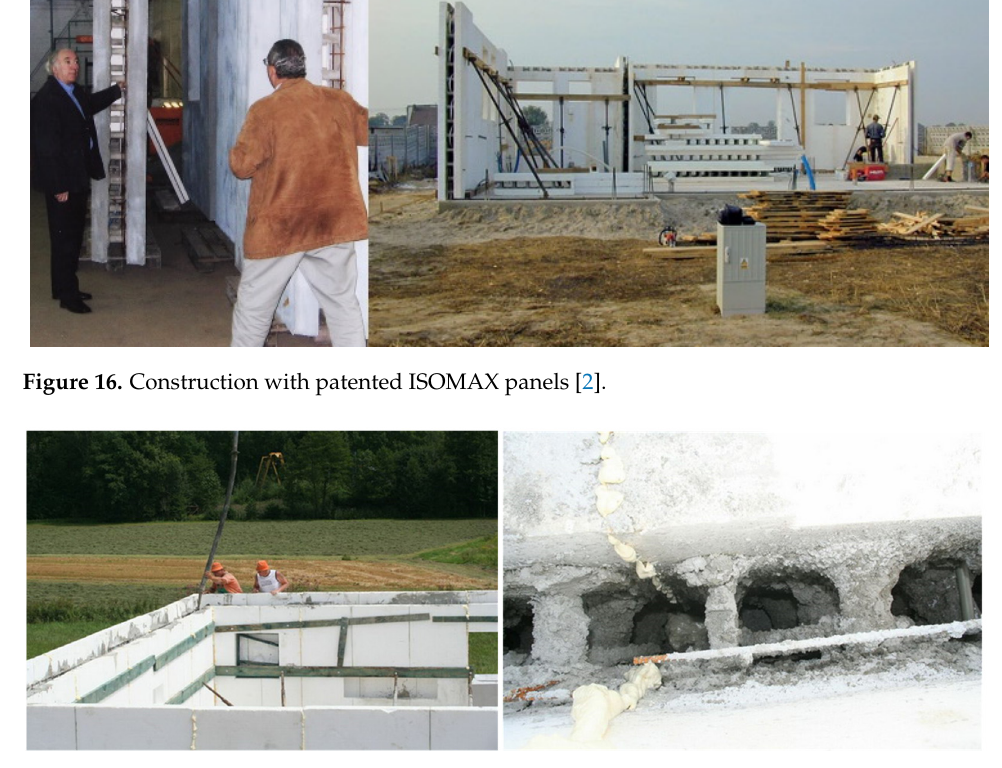
Figure 17. Construction with patented ISOMAX panels [2].